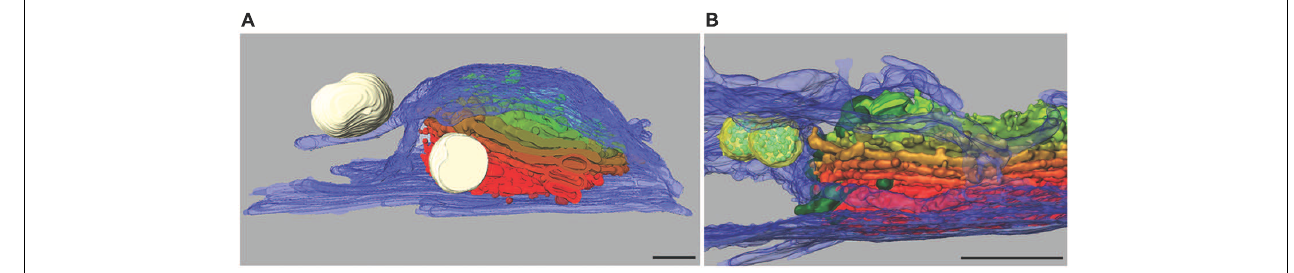
FIGURE 5 | 3-D reconstruction of Micrasterias dictyosomes from FIB-SEM series. Cis -side in red, trans- side in green. (A) The entire dictyosome is enwrapped by ER envelope (blue) (scale bar is 1 µ m). (B) Detail of another dictyosome showing the close spatial interaction between dictyosomal cisternae and the ER. Mucilage vesicles in white, multivesicular bodies in yellow (scale bar is 1 µ m). Reprinted with permission from Lütz-Meindl et al. (2015), (A) Copyright © 2015 Royal Microscopical Society and from Wanner et al. (2013) (B) , Copyright © 2013 Elsevier